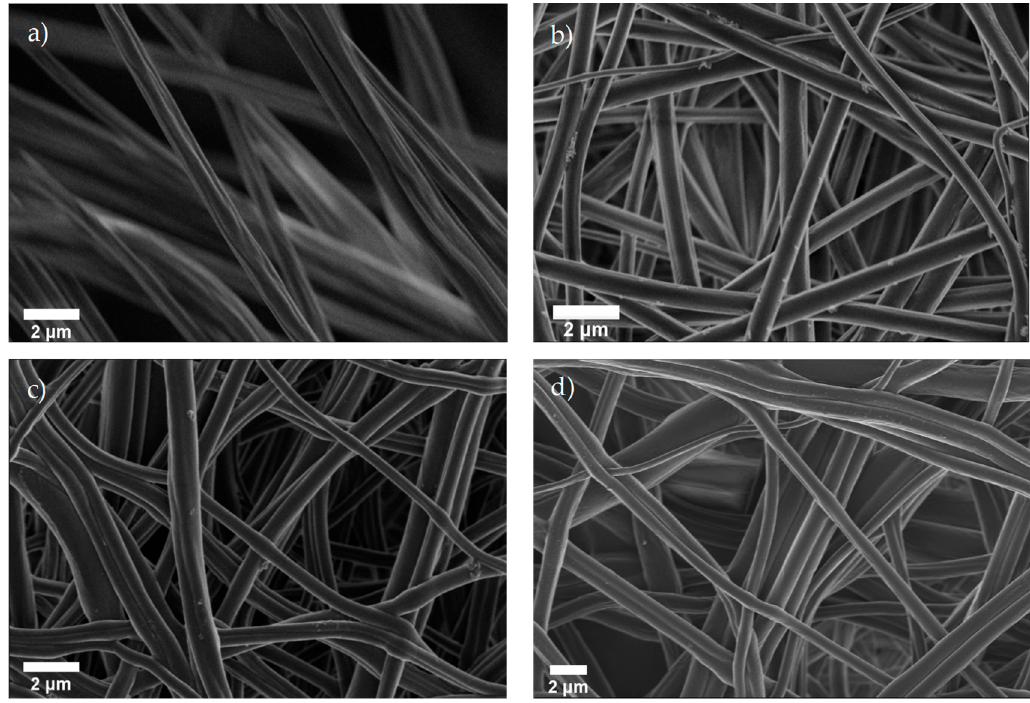
Figure 1. SEM images of ( a ) as-spun cellulose acetate (CA), ( b ) regenerated cellulose (RC), ( c ) alkyne- cellulose, and ( d ) biotin-cellulose nanofibers.